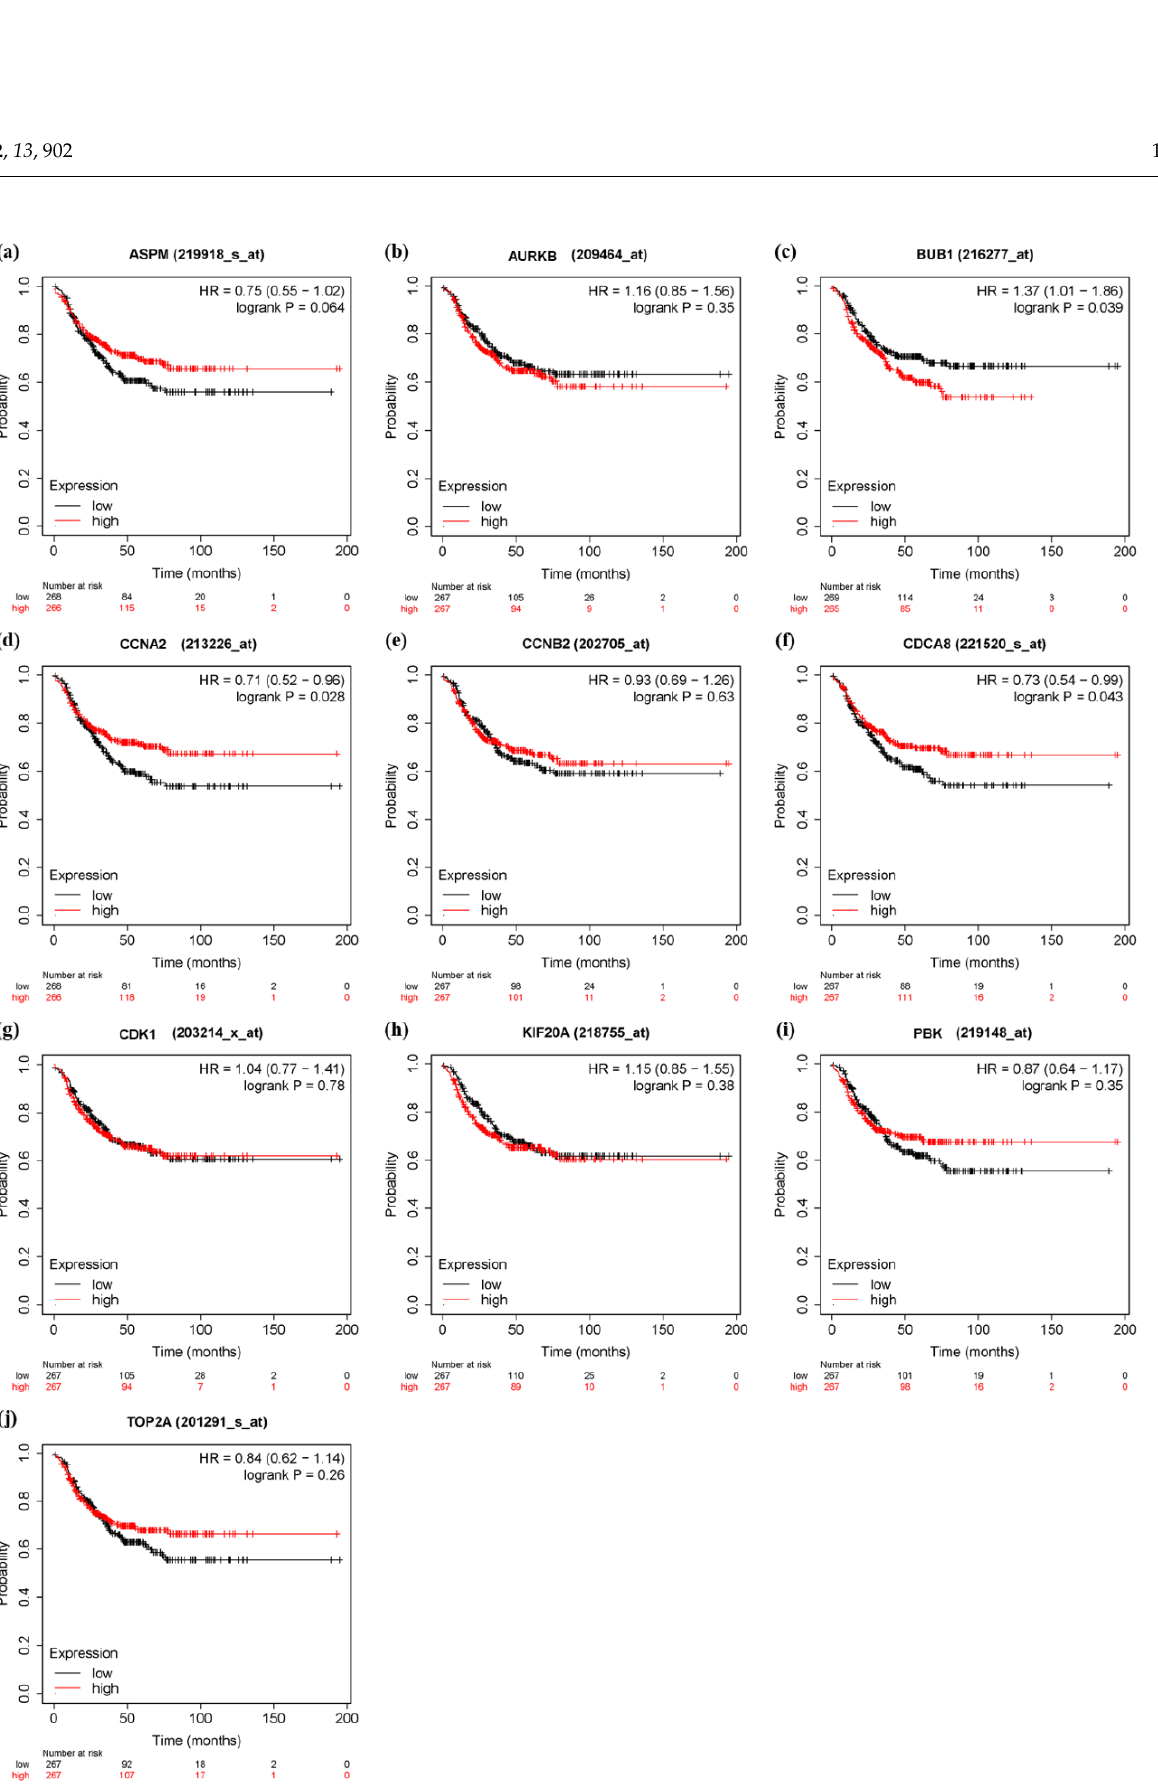
Figure 12. Disease free survival (DFS) analysis of 10 hub genes in TNBC patients by KM Plotter. ( n = 534) ( a ) ASPM ( b ) AURKB ( c ) BUB1 ( d ) CCNA2 ( e ) CCNB2 ( f ) CDCA8 ( g ) CDK1 ( h ) KIF20A ( i ) PBK ( j ) TOP2A.